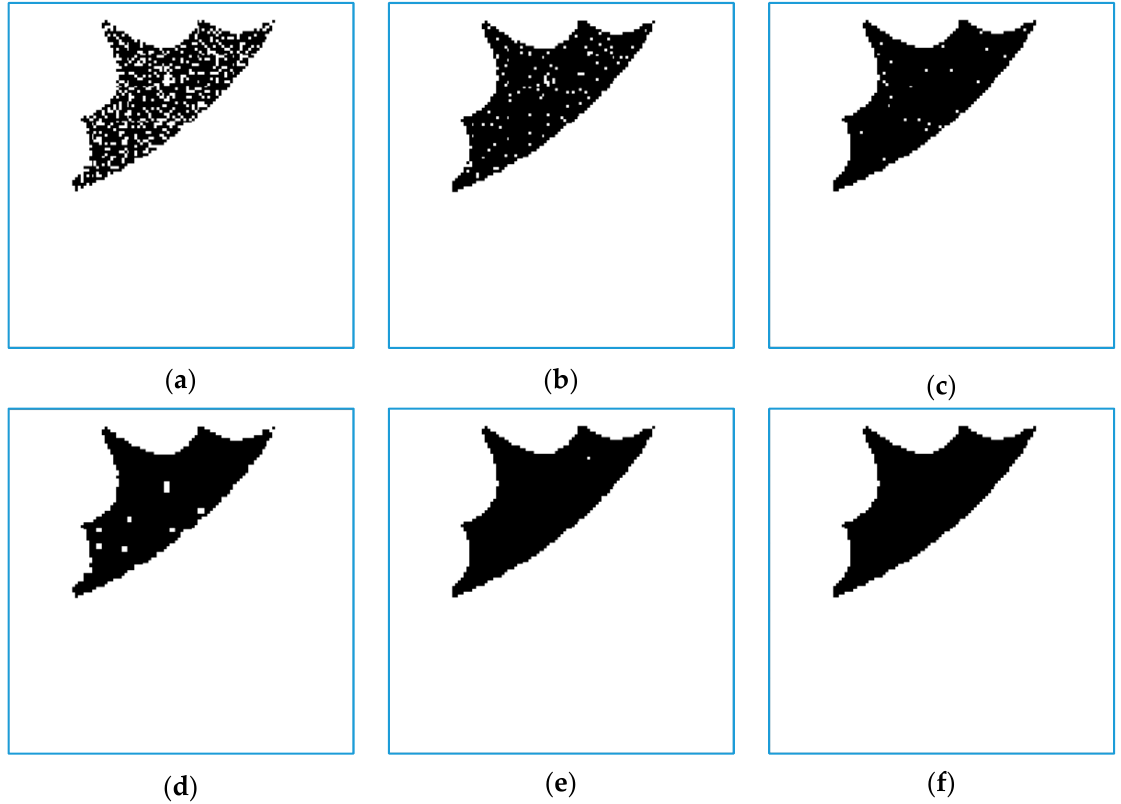
Figure 7. The first and second stage detection results. ( a ) 1st detection, α = 2; ( b ) 1st detection, α = 4; ( c ) 1st detection, α = 6; ( d ) 2nd detection, α = 2; ( e ) 2nd detection, α = 4; ( f ) 2nd detection, α =